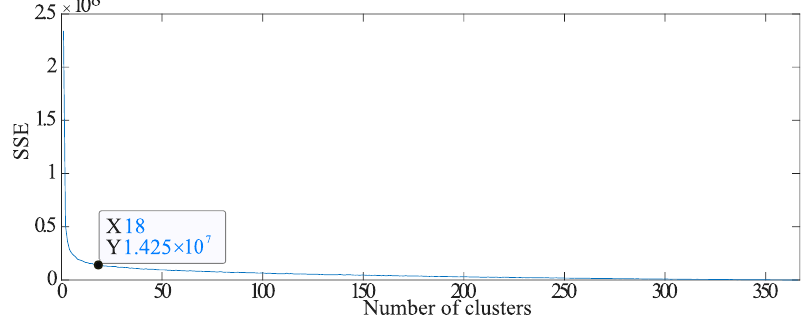
Figure 22. Elbow